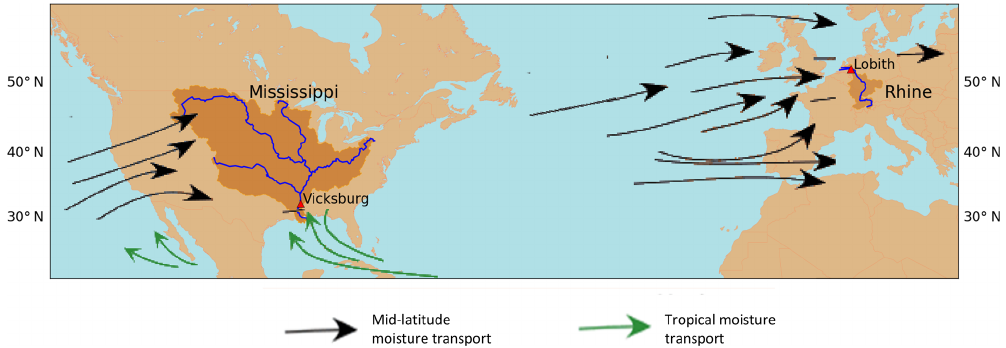
Figure 2. Map indicating the Rhine and Mississippi basins, the rivers, the used gauge stations (Lobith and Vicksburg), and the climatological location of mid-latitude moisture transport (black arrows) and tropical moisture transport (green arrows). Figure adapted from http://www.